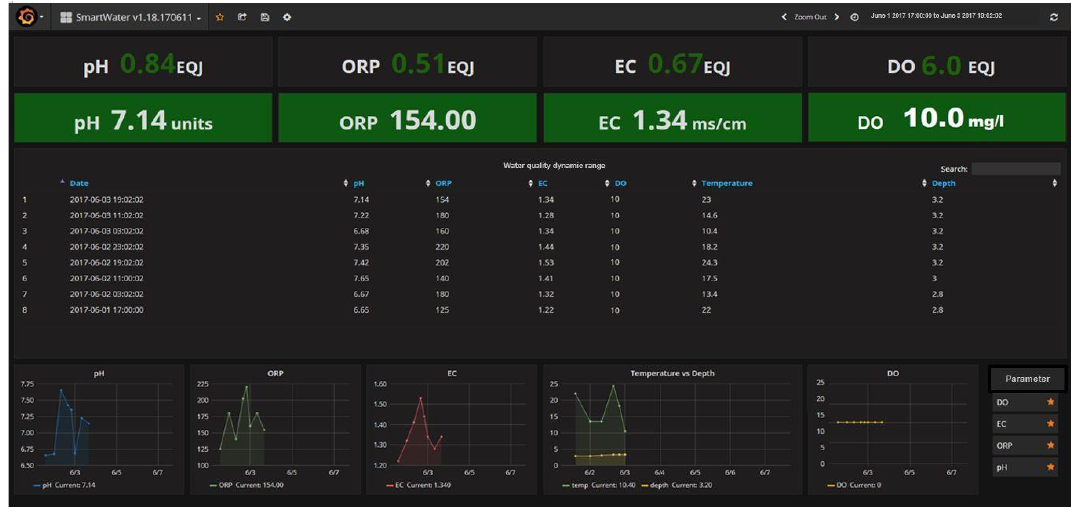
Figure 7. The main screen of the